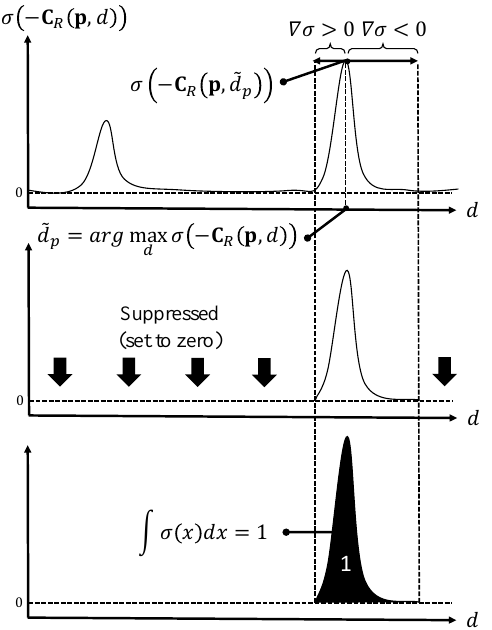
Figure 5. Illustration of the suppressed regression process. Top : determining the active regions; middle : suppressing the inactive regions; bottom : normalizing the active